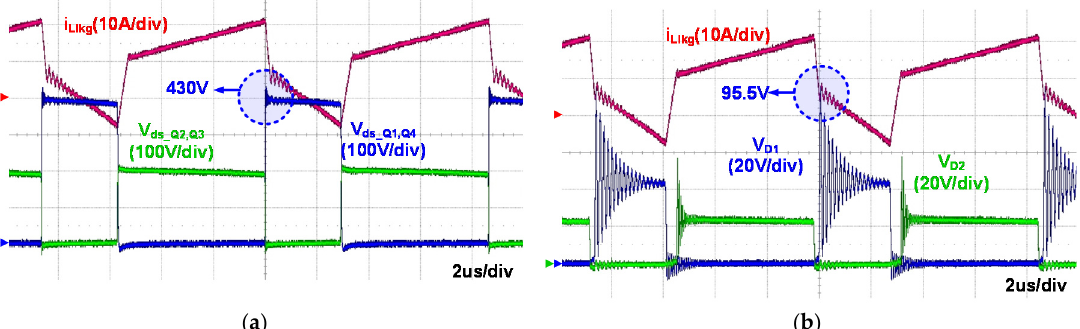
Figure 13. Key experimental waveforms at 270 V input and 100% load conditions ( D = 0.605). ( a ) Primary side key experimental waveforms. ( b ) Secondary side key experimental waveforms.